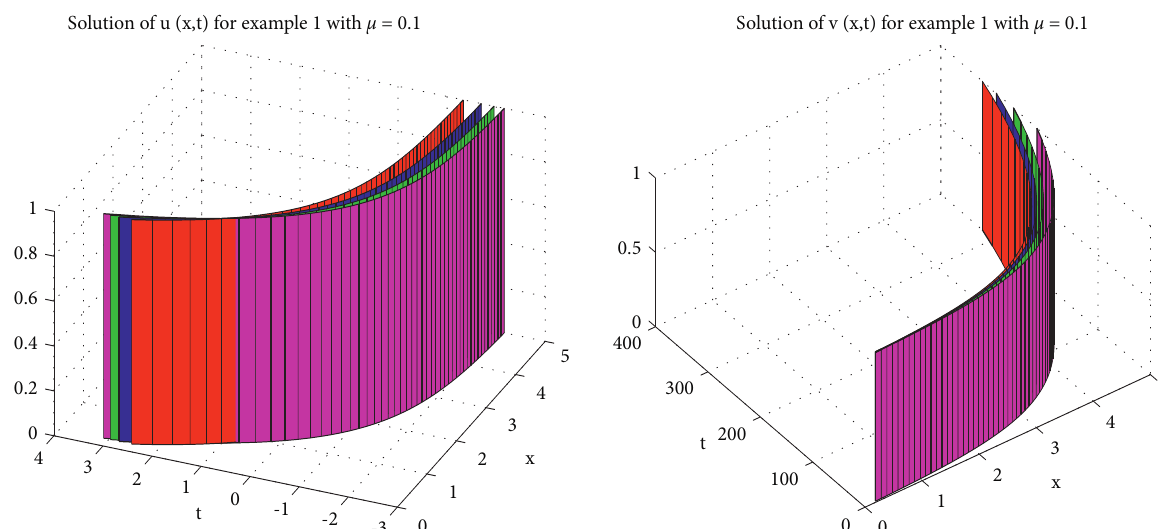
Figure 2: 3D graphical representation for u ( t, x ) and v ( t, x ) of equation